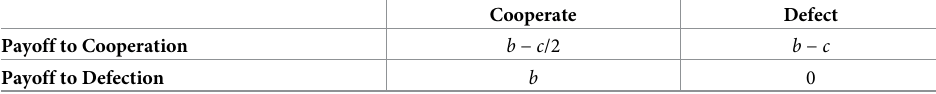
Table 2. Payoff matrix of the Snowdrift Game. In this social dilemma, a task has to be done and b is the benefit of accomplishing the task, while c is the cost for doing the task (where b ; c 2 R of the two players puts an effort to cooperate, the task would not be accomplished with a negative effect for both